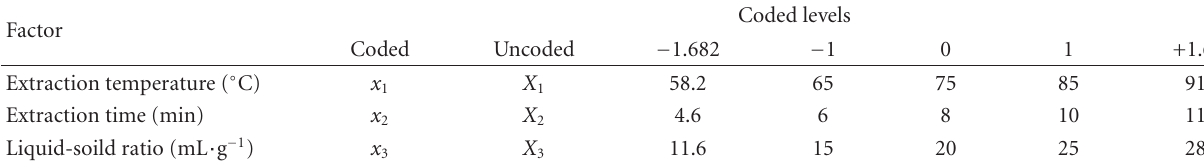
Table 1: Code and level of factors for the trials.